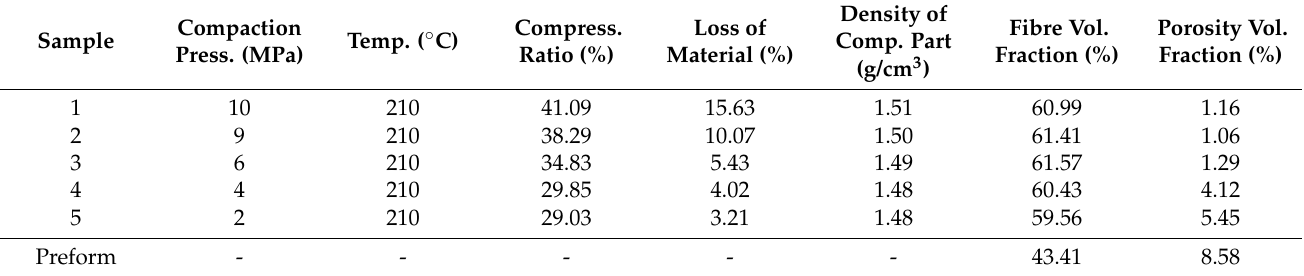
Table 1. Compression test results of the first five specimens, compressed at 210 ◦ C and 10 min of dwell time, with various compaction pressures. Appendix D gives the complete results of the experiments including measured standard deviation at each pressure